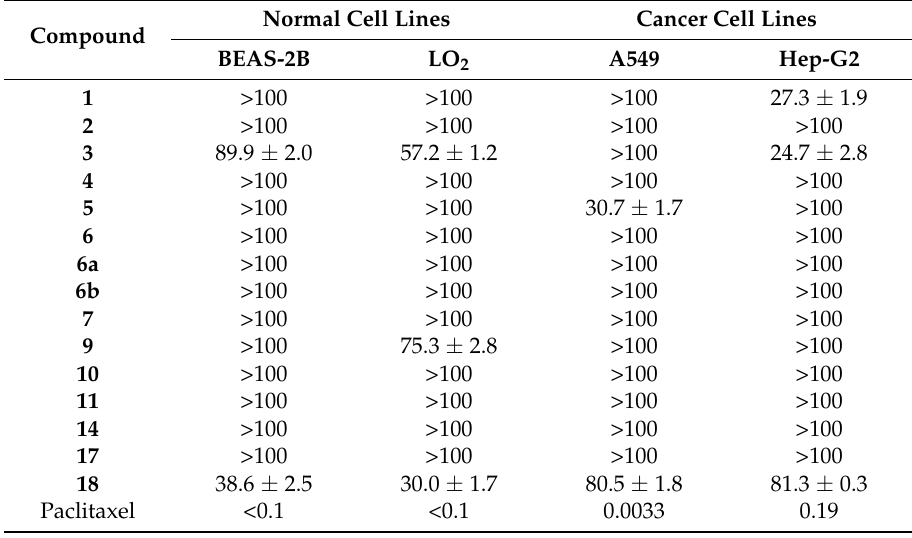
Table 3. Cytotoxicity (IC 50 , µ M) of compounds isolated from Aspilia species against various cell lines. Normal Cell Lines Cancer Cell Compound